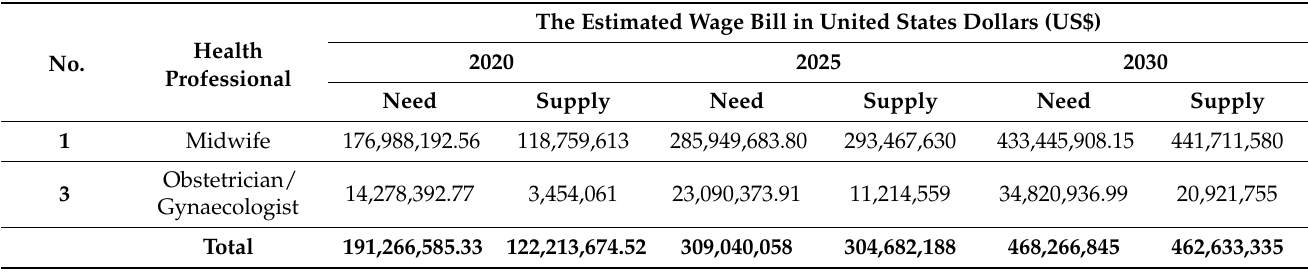
Table 4. Cost implications of the needs-based requirements and anticipated supply.